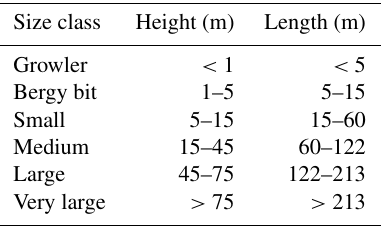
Table 1. Iceberg size classification defined by the International Ice